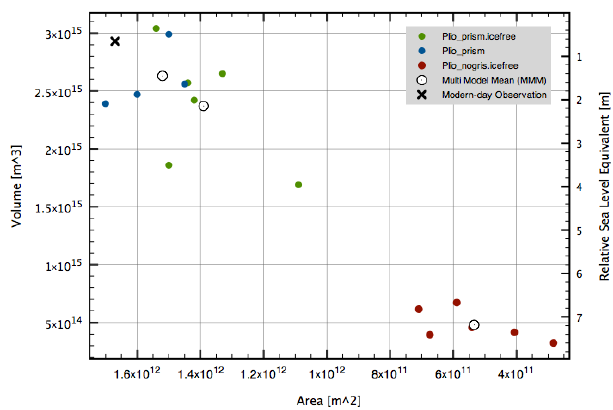
Figure 7. Ice sheet volume [m 3 ] and area [m 2 ] of Pliocene scenarios Plio prism . icefree (green), Plio prism (blue), and Plio nogris . icefree (red) with relative sea level equivalent [m] with respect to present-day reconstructions. Cross denotes volume and area for Bamber et al. (2001a), open circles indicate multi-model means (MMM) for the respective